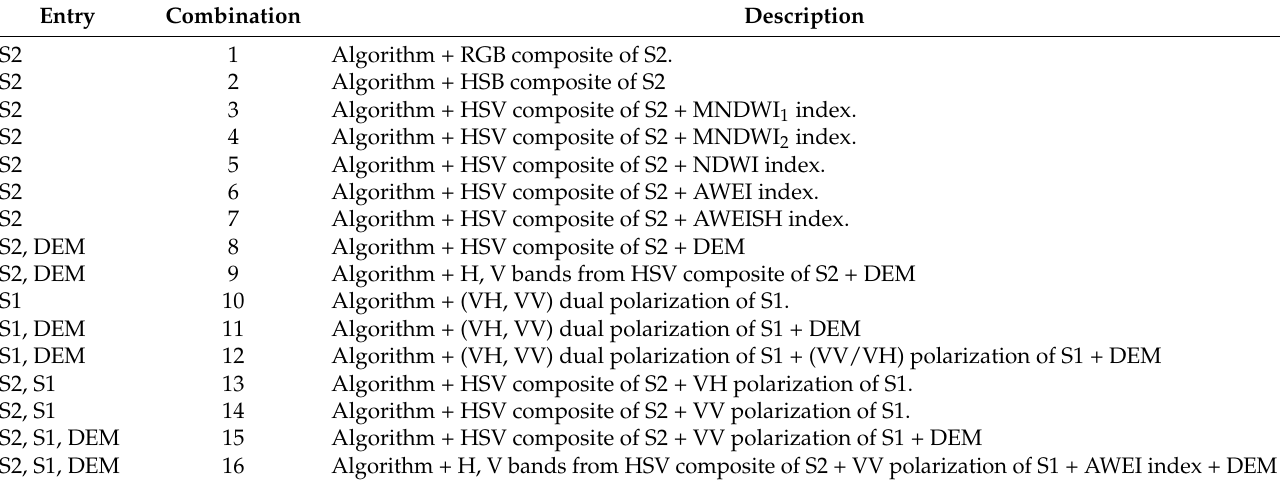
Table 3. Description of the inputs and their combinations for training and evaluating machine